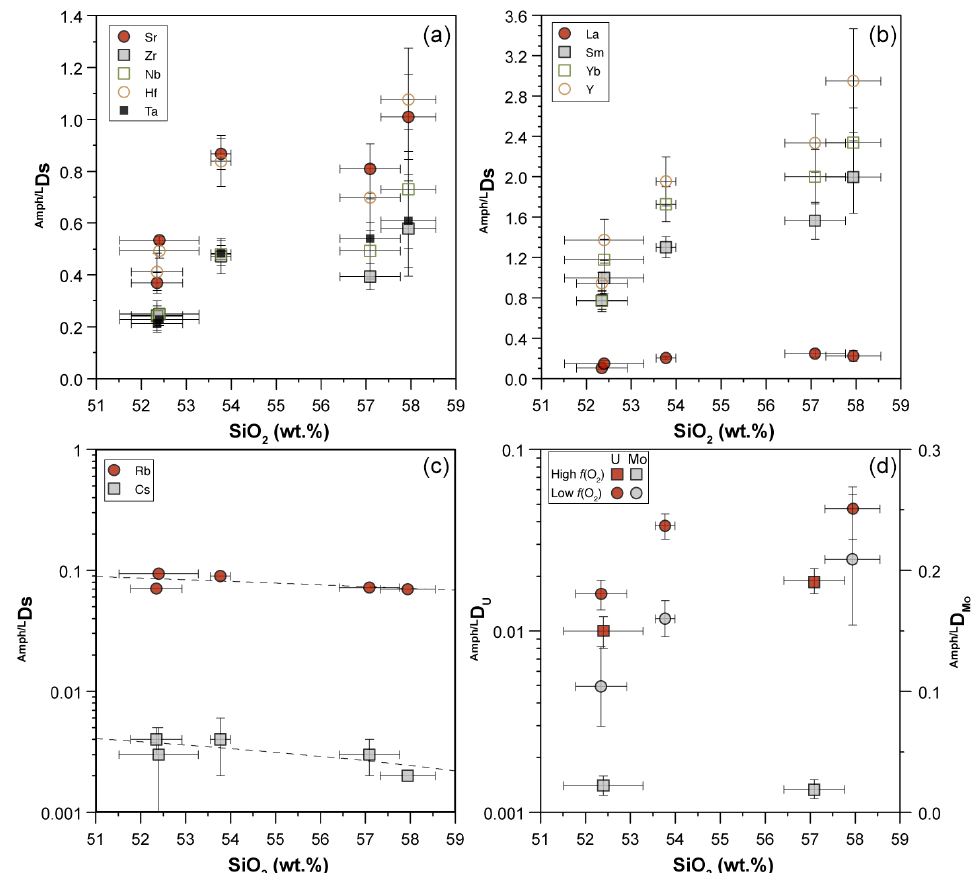
Figure 8. Correlations between the SiO 2 content (wt%) of the liquid in equilibrium with the amphiboles and the Amph / L D of key elements: Sr and HFSEs in (a) , REEs + Y in (b) , Rb and Cs (LILEs) in (c) , and elements with multiple oxidation state (U and Mo) in (d)